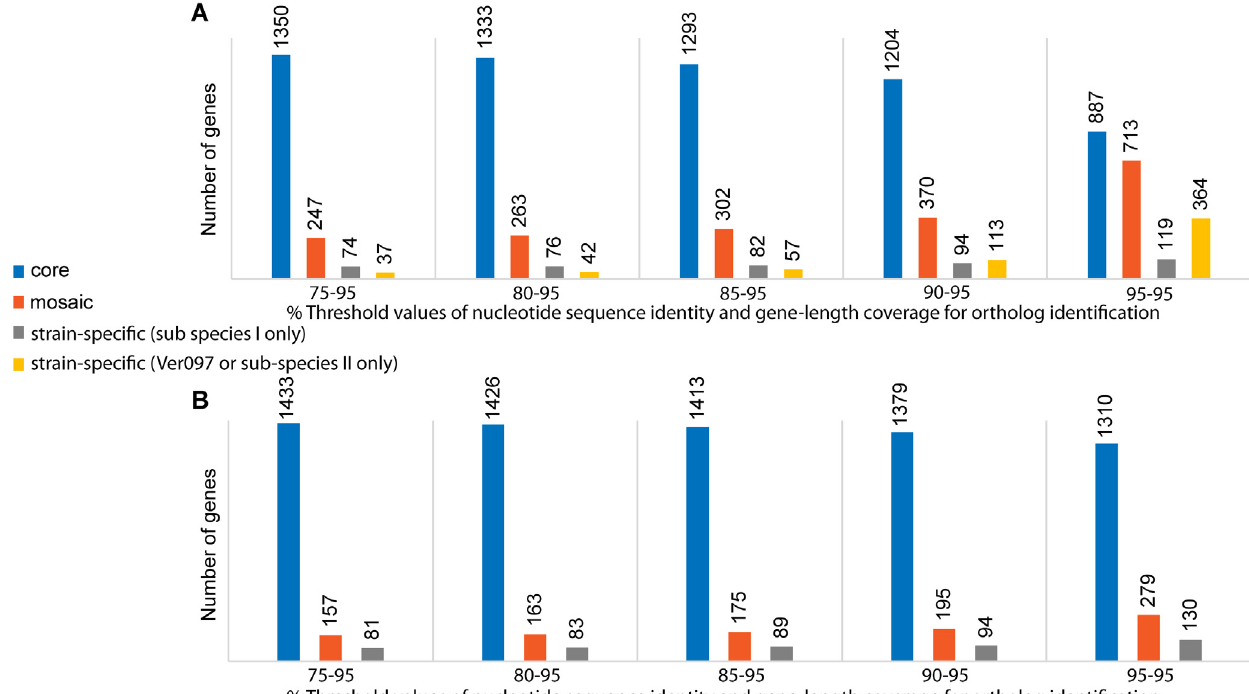
Fig 2. Pan-genomic distribution of core, mosaic and strain-specific genes. Analysis was performed among: (A) 13 strains, and (B) 12 strains (excluding Ver097) at different nucleotide sequence identity cut-offs while using a fixed 95% gene-length coverage cut-off for ortholog